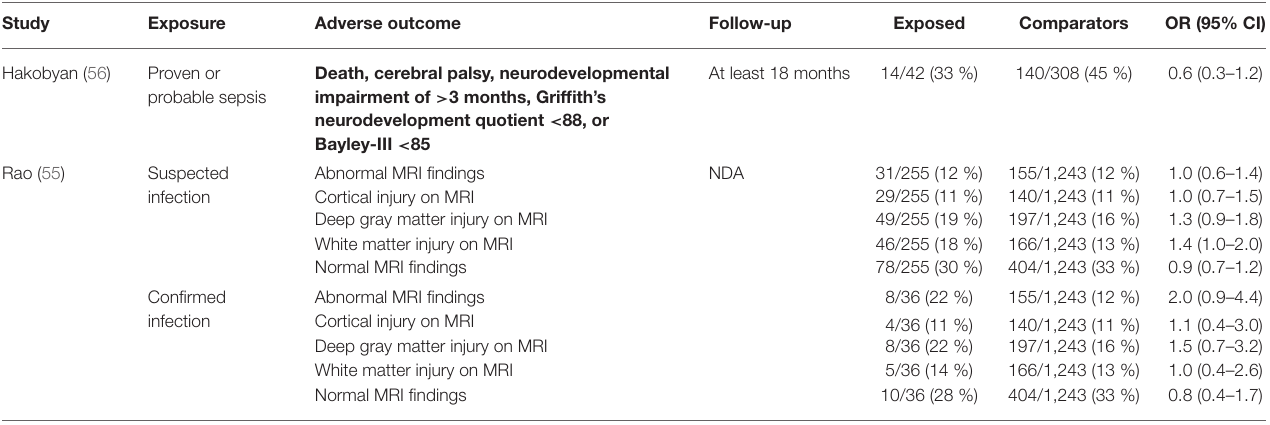
Study Exposure Adverse